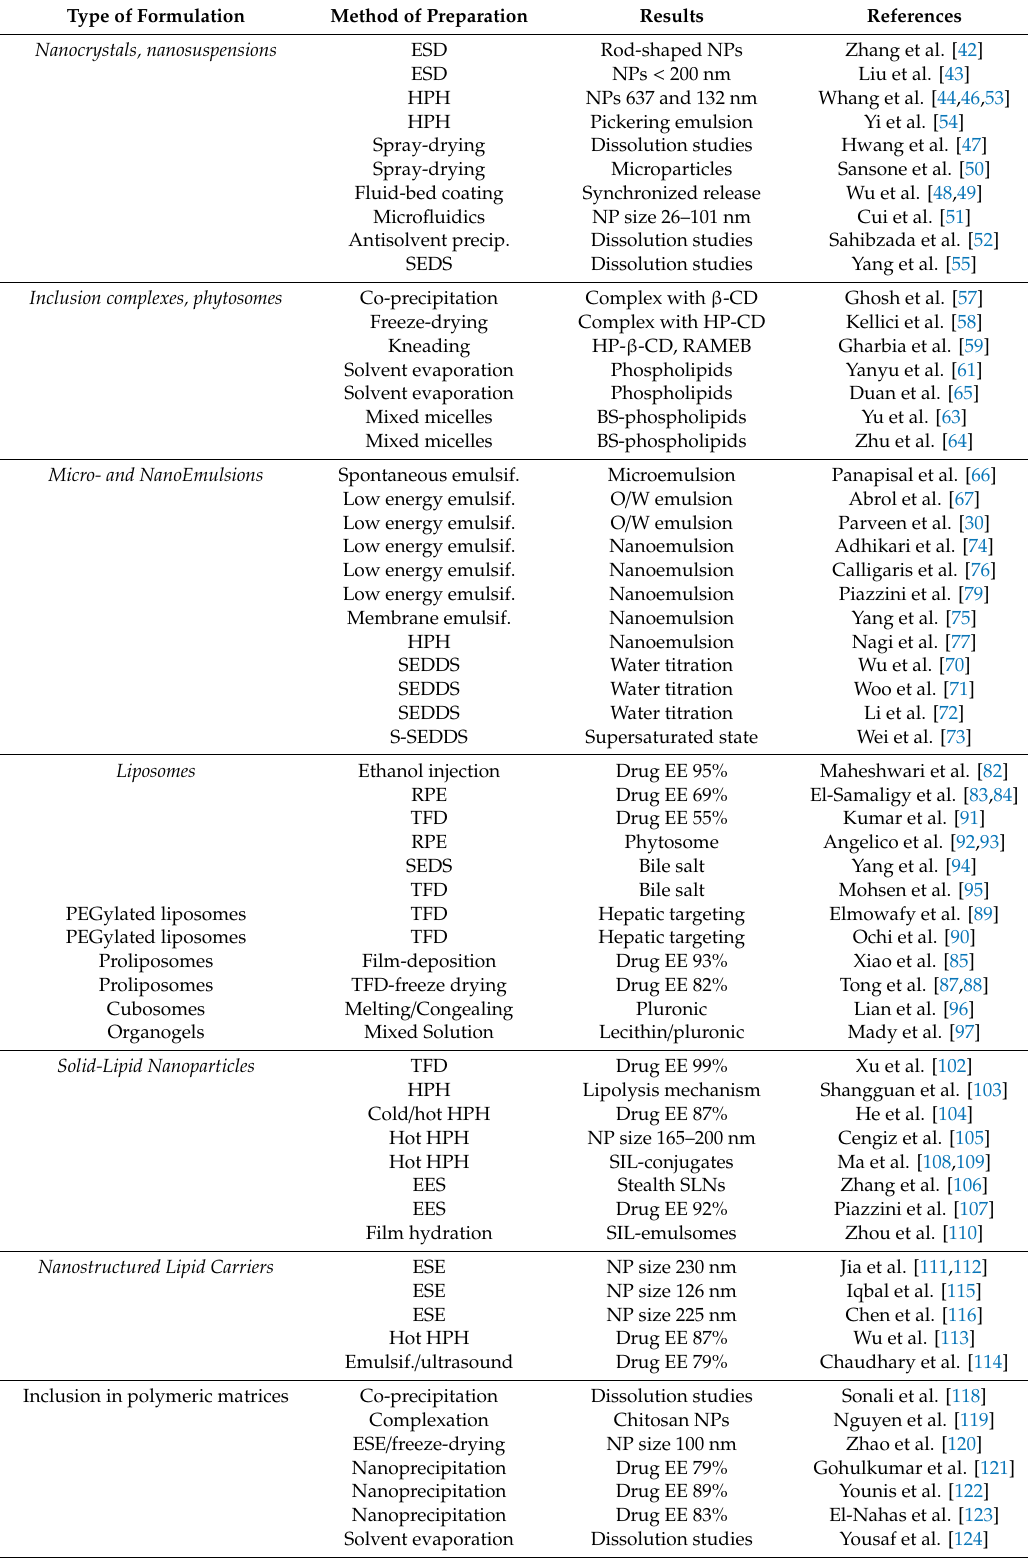
Table 1. Formulation approaches designed to improve solubility and bioavailability of